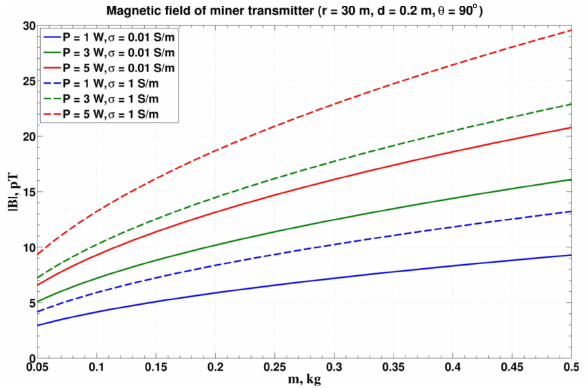
Figure 1. The magnetic field modulus at a distance of 30m from the field source (circular loop with a diameter of 0.2m) depending on the weight of the coil m , consumed power W and the conductivity of the medium σ .